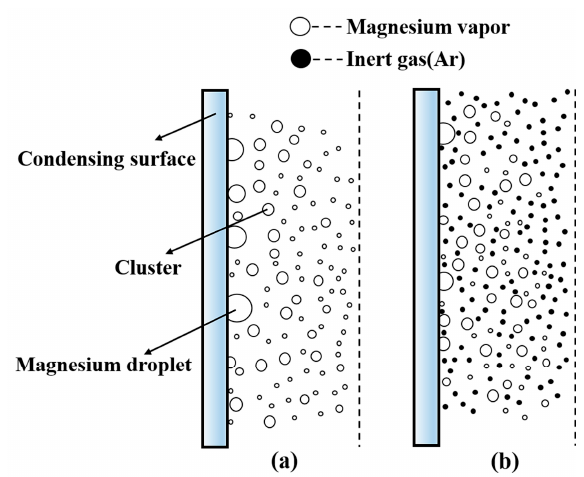
Figure 2. Physical model of Mg vapor condensation: ( a ) Magnesium vapor condenses without argon flow, ( b ) Magnesium vapor condenses with argon flow.